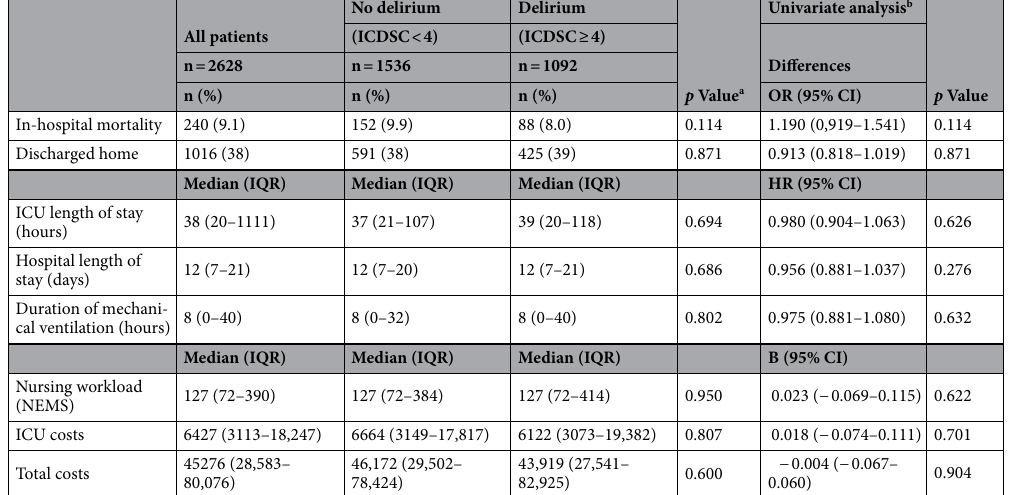
Table 4. Outcome of critically ill patients without malignancy: Comparison between delirious and non- delirious patients. B regression coefficient, CI confidence interval, HR hazard ratio, ICDSC intensive care delirium screening checklist, ICU intensive care unit, IQR interquartile range, NEMS nine equivalents of nursing manpower use score, OR odds ratio. a Comparison of the groups delirium vs. no delirium by Fisher’s exact and Mann–Whitney U tests. b Unadjusted differences between the groups delirium vs. no delirium described as OR, HR from univariate Cox regression and regression coefficients from linear regression after natural log transformation for NEMS and costs, each with its 95% confidence intervals.